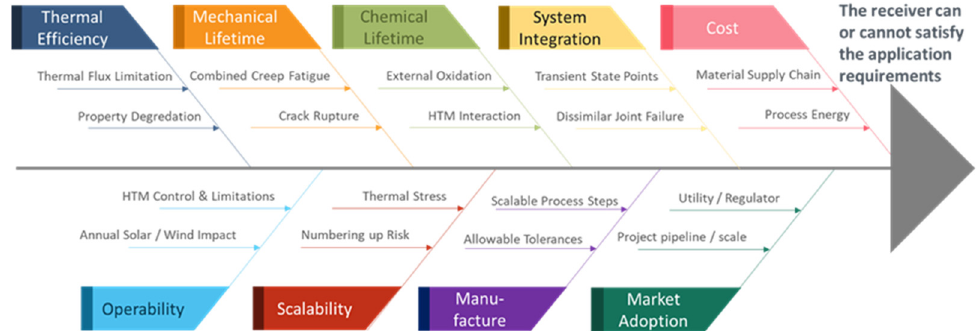
Figure 2. Generic receiver risk consideration via a fishbone diagram. Each receiver will be unique and require development of applicable risk categories. Each rib requires balancing and tradeoff with other risks. In tandem, these risks must be assessed to determine if the receiver can satisfy the spec- ified CST application. specified CST